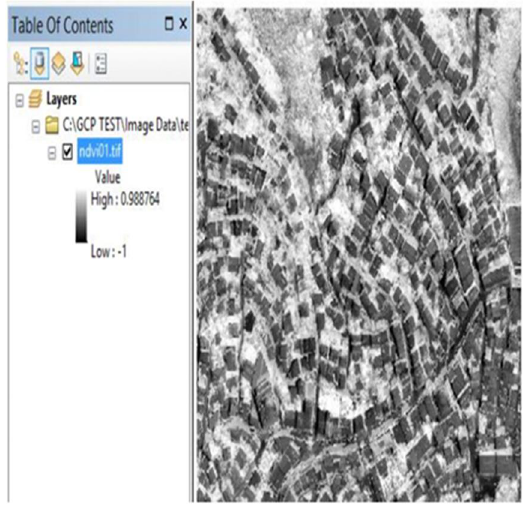
Figure 9: NDVI image. After applying an absolute threshold value to the NDVI image, a binary image (Figure 10) was created with a value of 0 indicating the non-vegetation features (i.e. black colour pixels) and value of 1 indicating the vegetation features (i.e. white colour pixels). The threshold value for NDVI image was estimated experimentally as 0.3.